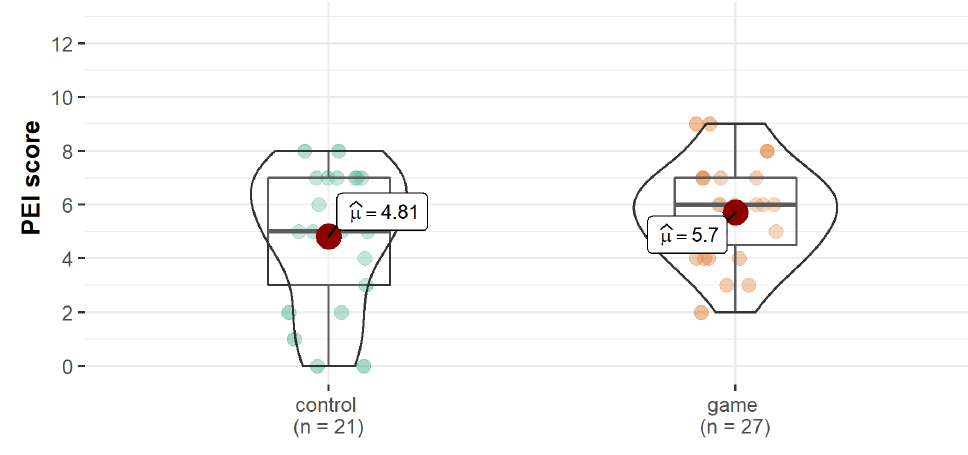
Figure 9. Results of Patient Enablement Instrument (PEI).